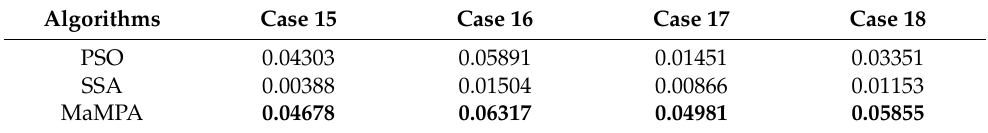
Table 12. Hypervolume comparison of MOOPF problems in the IEEE 118-bus system.